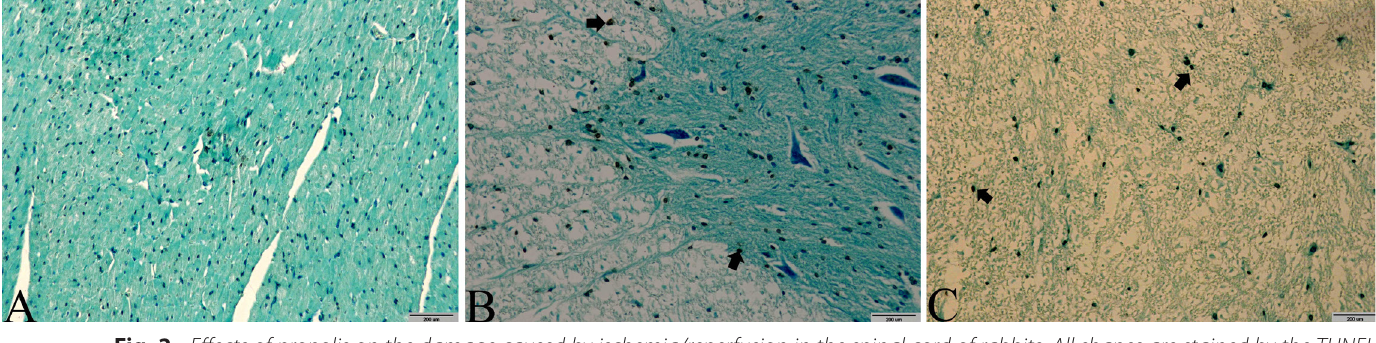
Fig. 2 - Effects of propolis on the damage caused by ischemia/reperfusion in the spinal cord of rabbits. All shapes are stained by the TUNEL technique. Note: cells stained brown show TUNEL-positive cells (arrow). (A), (B) 10x and 200 µm were used as the original magnification.